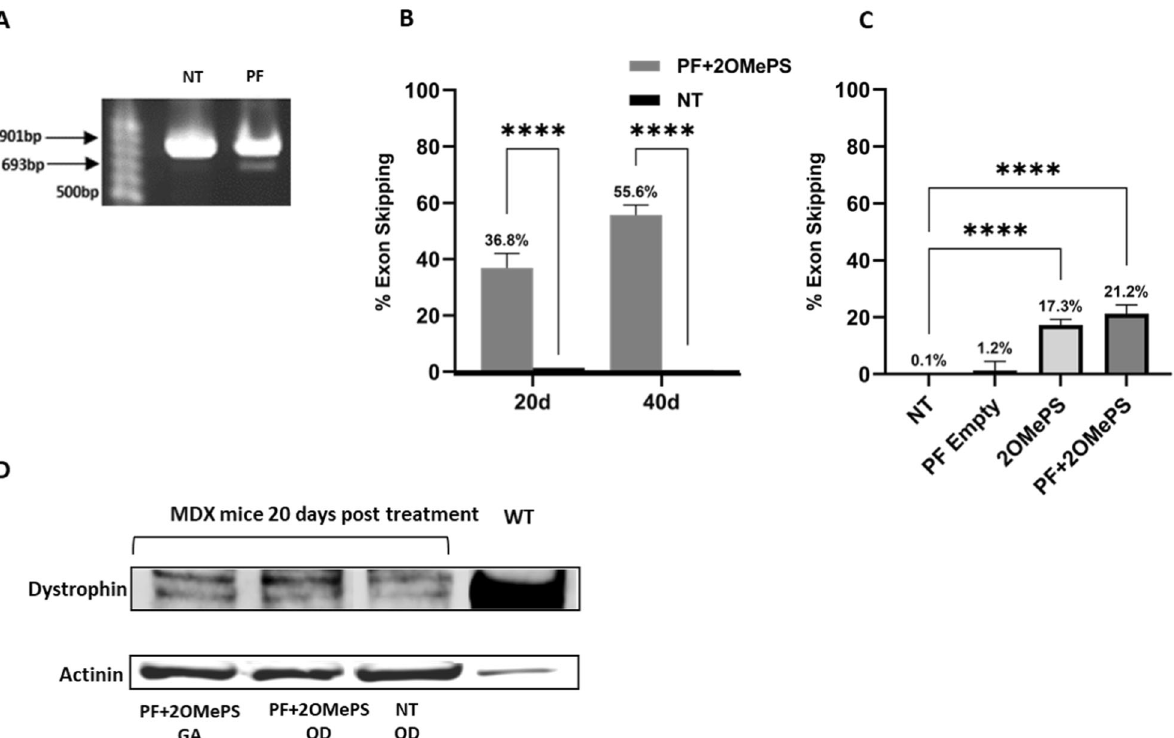
Fig. 4 Exon skipping and dystrophin expression. A Representative nested PCR of RNA extracted from GA muscle injected intrafemorally (IF) with 1 µg of 2OMePS/PEI polyplexes loaded in PF microspheres. A 901 bp band is observed in the treated group and the non-treated muscle; this band represents the non-skipped product of the PCR. A 693 bp band was observed only in treated muscle; this band represents the truncated product with exon 23 skipped. B The PCR products were quanti fi ed for the percentage of exon skipping after 20 days and 40 days post-IF injection. C Percentage of exon skipping after 30 days post-IM injection. Each PCR reaction was performed in triplicate, **** P < 0.0001 analyzed using an ordinary one-way ANOVA test compared to NT mice. D Dystrophin expression of GA and QD muscles measured by WB analysis of mice 20 days post IF injection of 2OMePS loaded PF MPs compared to NT mice and to WT mice. Actinin was used for marginally lower than the microsphere-treated muscles. No dystrophin expression was observed in muscles injected with empty PF microspheres and non-treated mdx mice. The quanti- fi cation of the dystrophin expression was performed using IMARIS image analysis software (Figure S4). For each image, dystrophin positive fi bers were counted, and their fl uorescence intensity was quanti fi ed and normalized to the fl uorescence intensity back- ground value obtained from the non-treated mdx mice specimens. Higher fl uorescence intensity was observed after treatment with 2OMePS loaded PF microspheres (Fig. 5B). The number of dystrophin-positive fi bers was counted and presented in Fig. 5C.